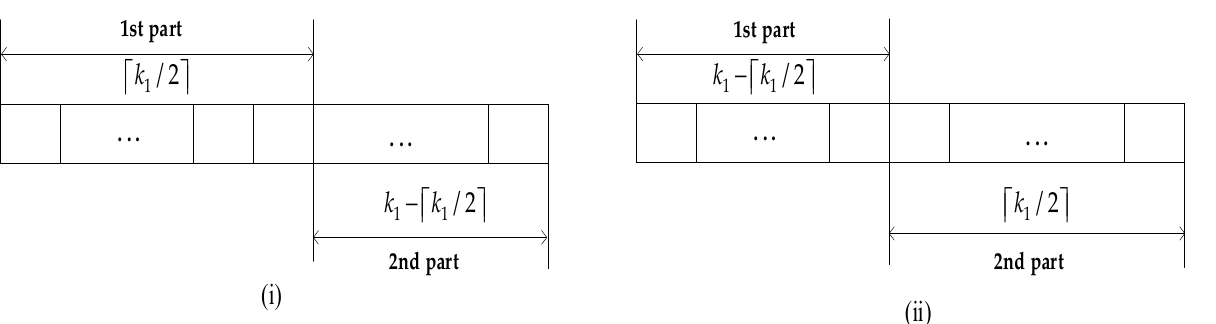
Figure 3. Symmetric structures of k 1 symbols ( i ) more positions are in the first part ( ii ) more positions are in the second part.